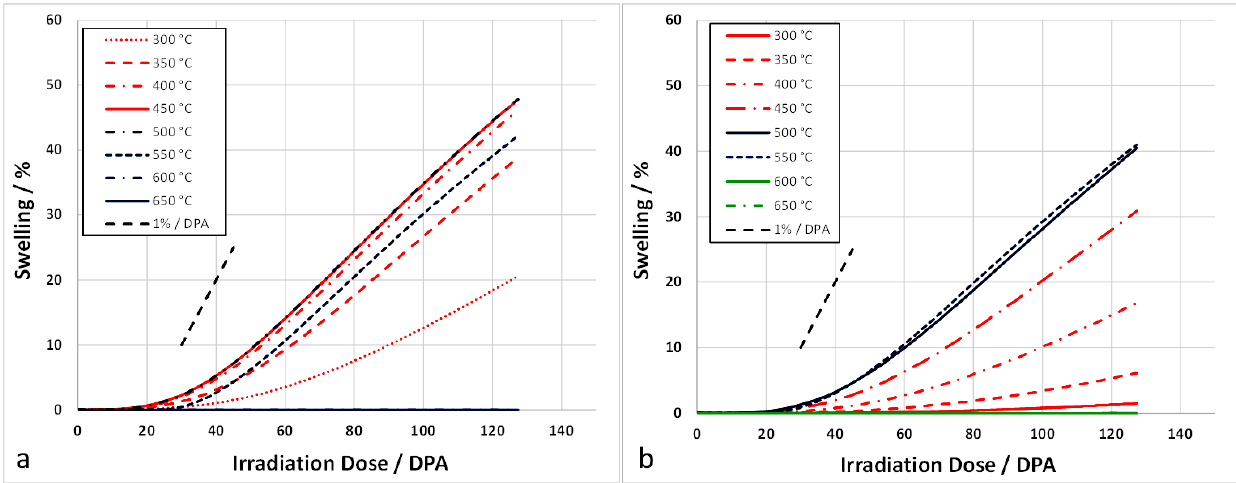
Figure 28. Calculated swelling of for 316 SS as a function of dose (DPA) at various temperatures in EBR-II for a cavity nucleation density of 10 21 m −3 and recombination coefficients of: ( a ) 10 20 × D i and ( b ) 100 × 10 20 × D i , where D i is the interstitial diffusion coefficient. The dislocation density rises from ρ d = 2 × 10 14 m −2 in the cold-worked condition to 10 × 10 14 m− 2 after irradiation to approximately 10 dpa. FMD production rate = 2.52 × 10 −8 dpa s −1 , He production rate ~0.27 appm/dpa, 30%, interstitial bias for dislocations, vacancy formation energy = 1.6 eV, vacancy migration energy = 1.4 eV, and interstitial migration energy = 0.15 eV.